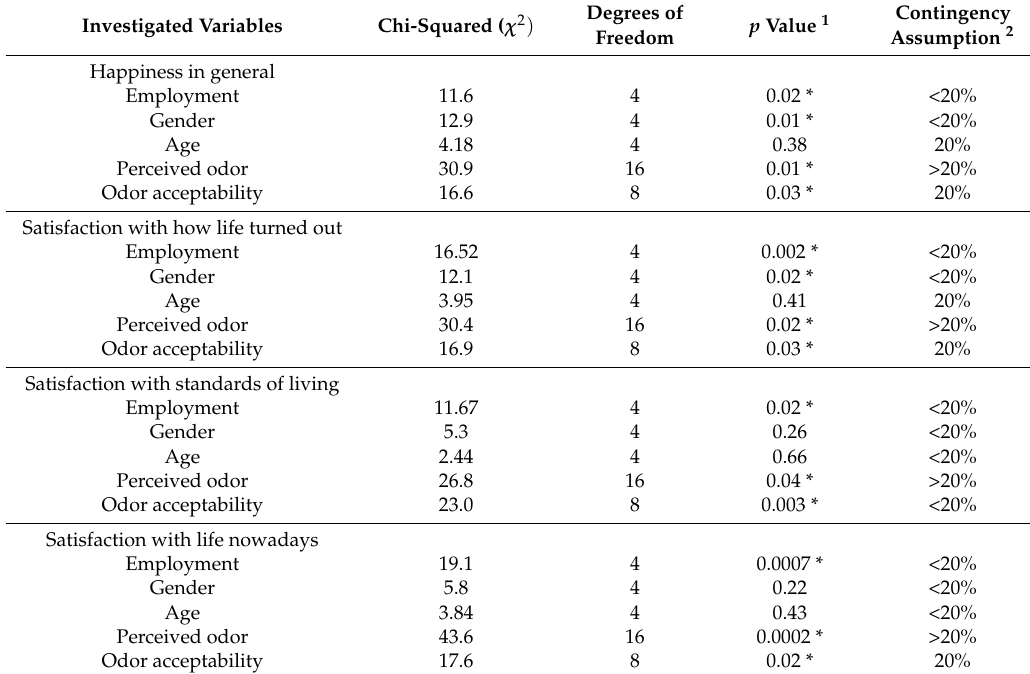
Table 4. Chi-squared test for independence between all subjective well-being (SWB) measures and the independent